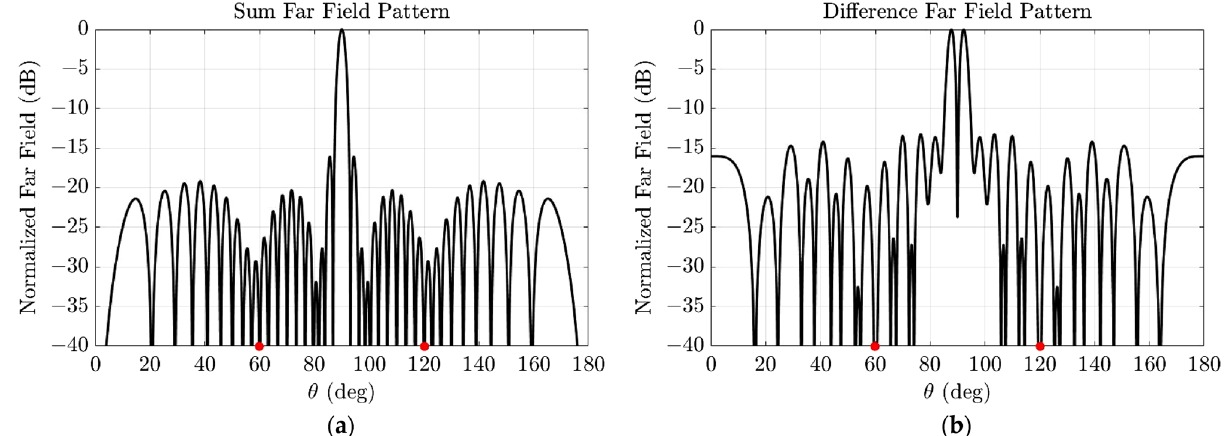
Figure 1. Normalized far field patterns resulting from the compromise solution reported in Table 2 fixing a deep null at 60° and generated by the relative excitations shown in Table 3. ( a ) Sum pattern solution: two halves of the linear array in phase. ( b ) Difference solution: two halves of the linear array out of phase. The red dots indicate the obtained deep null positions.